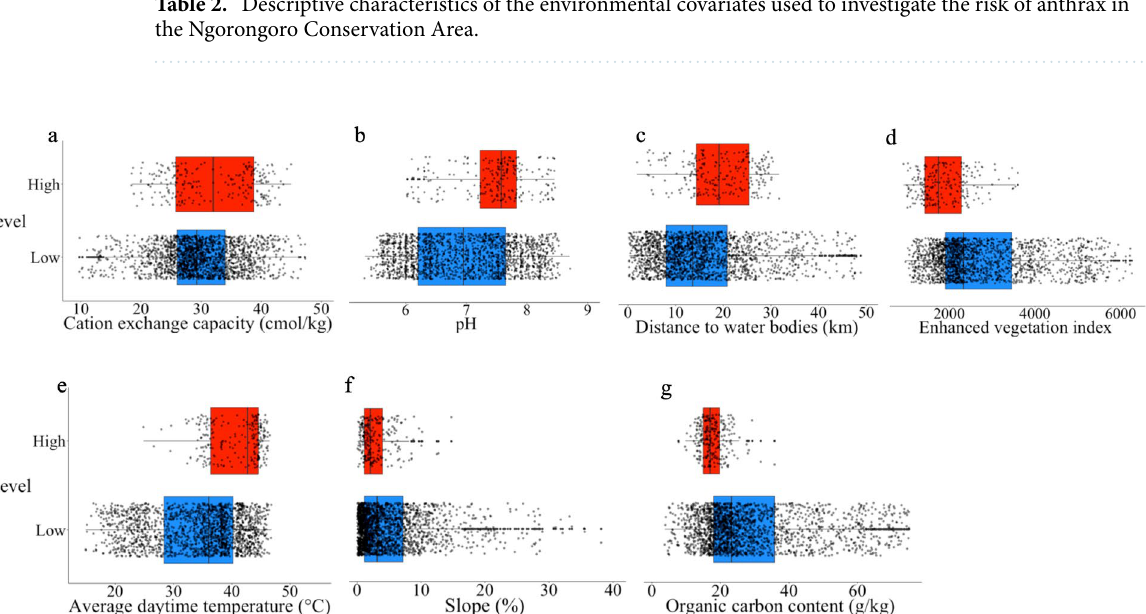
Figure 4. Boxplots of environmental variables. Data values, median, lower and upper quartiles are shown for points falling in both anthrax high- (red) and low-risk (blue) areas as defined through participatory mapping in the Ngorongoro Conservation Area. Plots are shown for ( a ) cation exchange capacity, ( b ) pH, ( c ) distance to inland water bodies, ( d ) average enhanced vegetation index, ( e ) average daytime land surface temperature, ( f ) slope and ( g ) predicted topsoil organic carbon content. This visual exploration does not account for spatial autocorrelation of